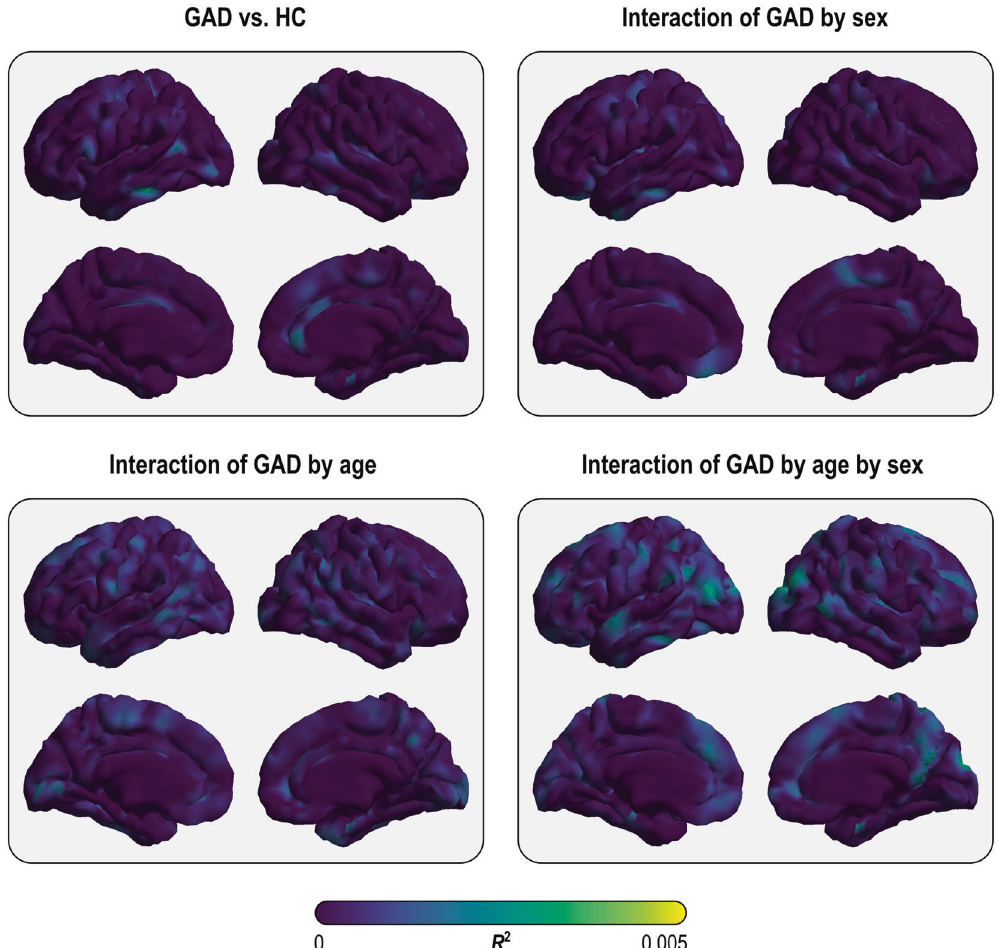
Fig. 3 Effect sizes from the main analysis for vertex-wise cortical thickness with the design that included global brain measures as nuisance variables. None of these was statistically signi fi